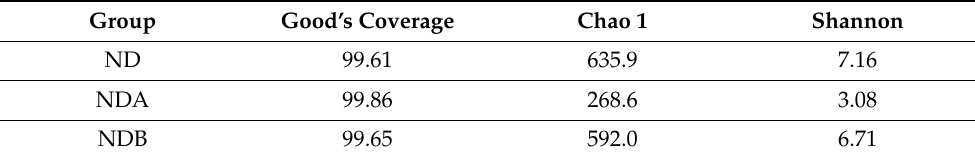
Table 1. Bacterial diversity from intestinal contents of